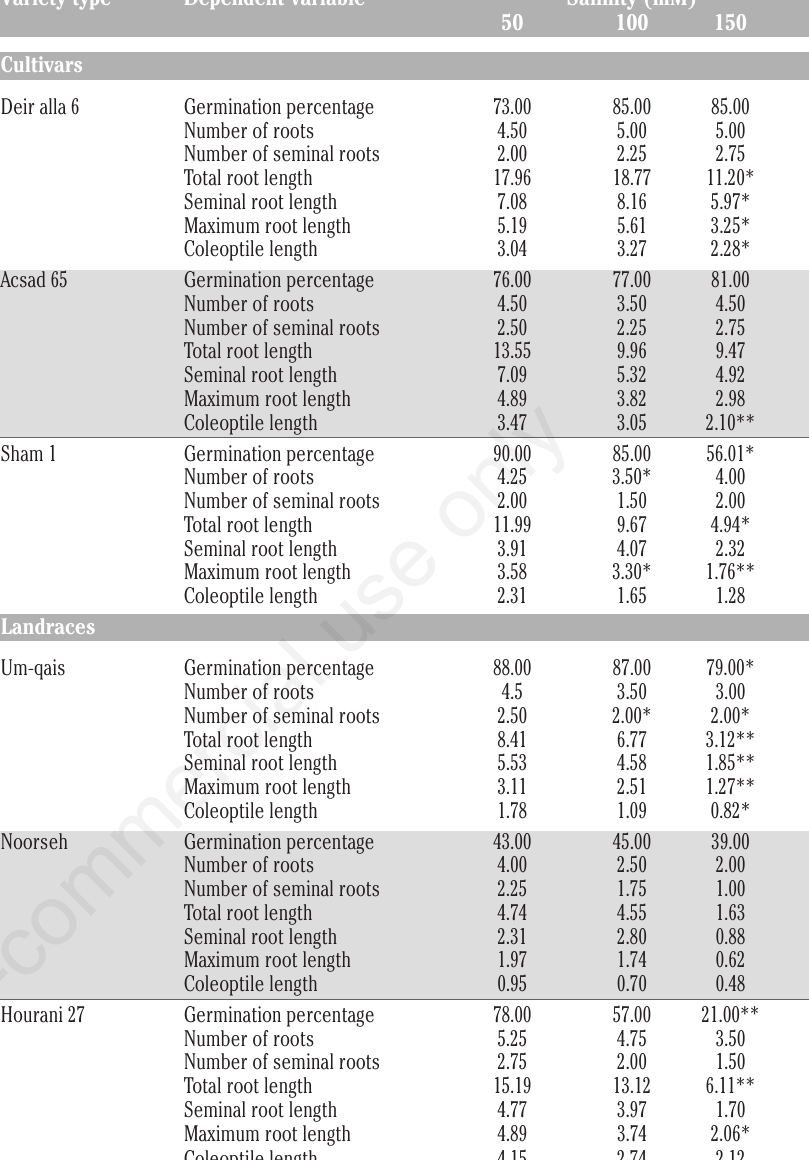
Table 3. Mean estimates, based on four independent replicates, of germination percentage and root architectural traits of the studied durum wheat varieties (cultivars and lan- draces) under three salinity concentrations (50, 100, and 150 mM NaCl) and their vari- ations relative to the control (0 mM NaCl) as measured using a one-way ANOVA.